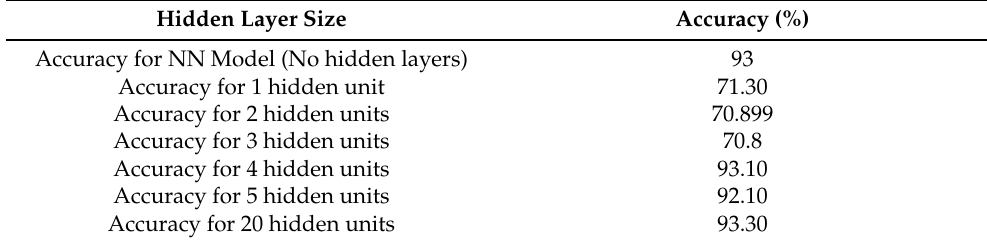
Table 2. Accuracy over different numbers of hidden nodes in the hidden layer.